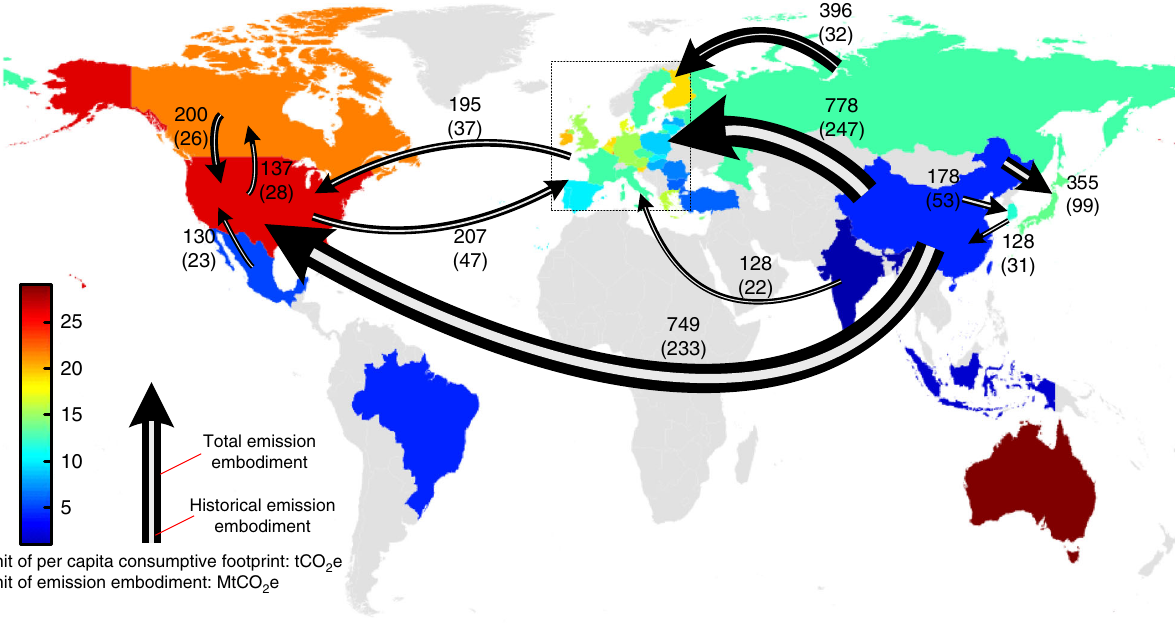
Fig. 6 Per-capita dynamic footprint and emissions embodied in major bilateral trade fl ows in 2009. The region in the dotted box represents the EU. The color of the territory indicates national per-capita dynamic footprints. The numbers associated with bilateral trade are total embodied emissions (outside parentheses) and cumulative embodied emissions (inside parentheses). The arrow illustrates the GHG emissions embodied in the goods produced in one region and transported to another, but does not necessarily imply any net regional emissions change caused by the